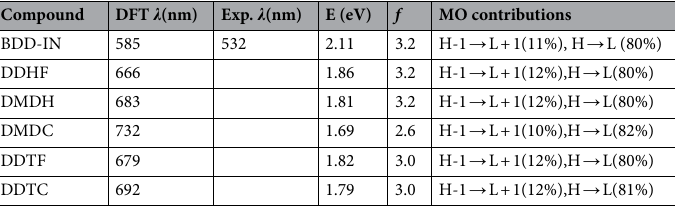
Table 2. Wavelength, excitation energy and oscillator strength of studied compounds. f = oscillator strength, MO = molecular orbital, H = HOMO, L = LUMO.